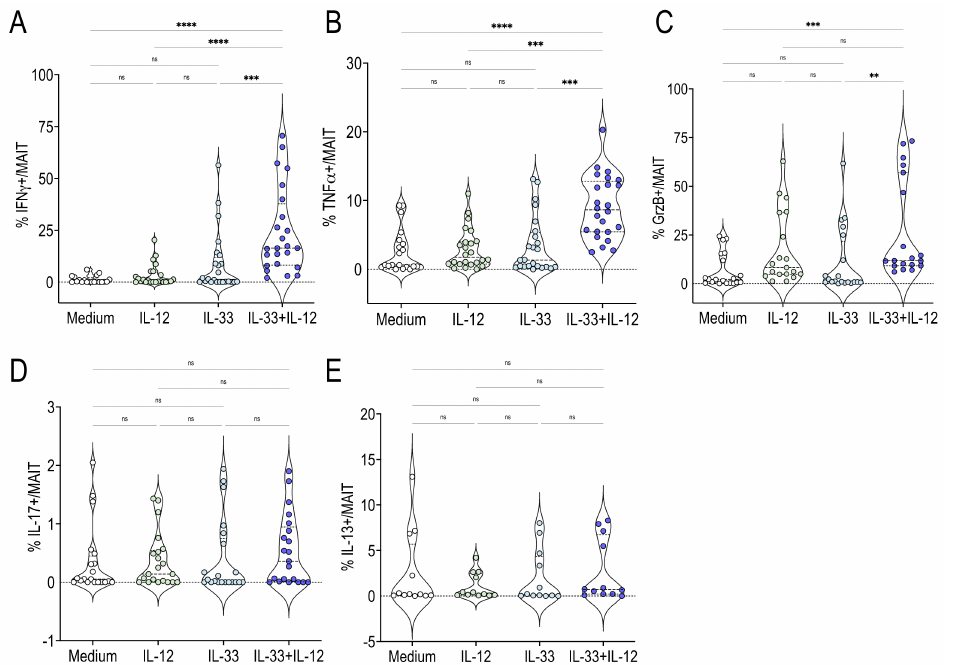
Figure 2. IL-33 + IL-12 induce IFN γ and TNF α production by human MAIT cells. (A,B,C,D,E) percentages of IFN γ + ( A ), TNF α + ( B ), GrzB+ ( C ), IL-17+ ( D ) and IL-13+ ( E ) cells among gated MAIT cells stimulated for 48 h with IL-12, IL-33 or IL-33 + IL-12. Bars indicate medians and quartiles. Data were acquired from six donors in two or four experiments. ** p < 0.01; *** p < 0.001; **** p < 0.0001.